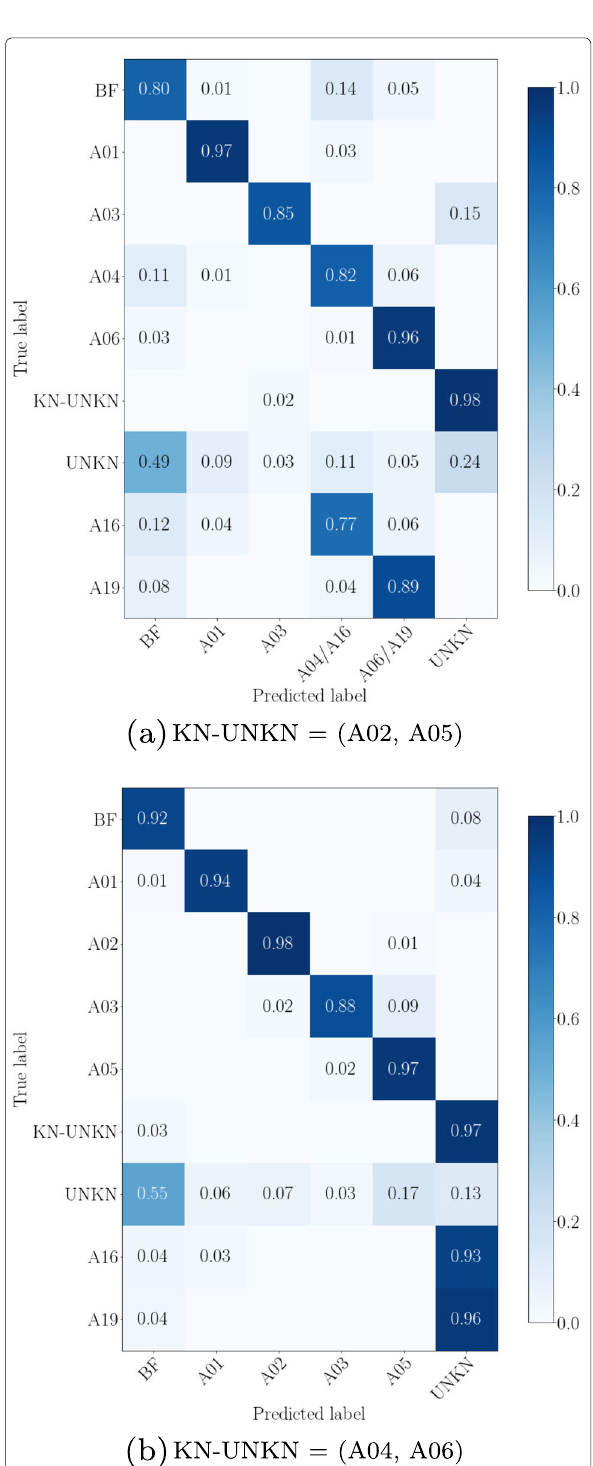
Fig. 6 Confusion matrices showing Bicoherence + STLT open-set results on the union of D dev and D